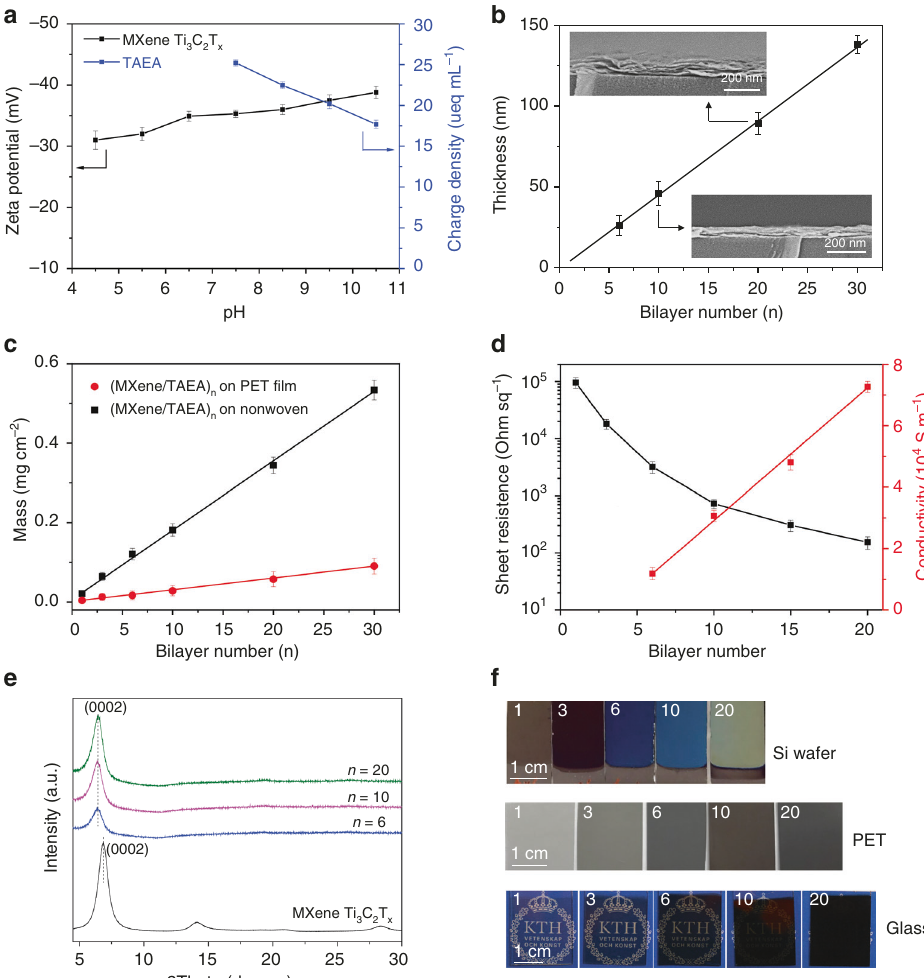
Fig. 2 Characterization of (MXene/TAEA) n multilayers. a Zeta potential of Ti 3 C 2 T x MXene colloidal solution and charge density of TAEA solution as a function of pH. b The average thickness of (MXene/TAEA) n measured from SEM cross-section images vs . bilayer number n. The inset b is the corresponding cross-sectional SEM images of (MXene/TAEA) n on silicon wafers. c The mass loading of (MXene/TAEA) n onto PET sheets and nonwoven fi bers vs. n. d Sheet resistance and electric conductivity of (MXene/TAEA) – e show statistical values from 6 n on silicon wafers vs. n. The data in a measurements in each data point. e XRD patterns of (MXene/TAEA) n vs. n, and pure MXene Ti 3 C 2 T x fi lm. f Digital photographs of the (MXene/TAEA) n on silicon wafers, PET sheets and glass slides vs. n. The color change on Si wafers is owing to different optical characteristics of various thickness